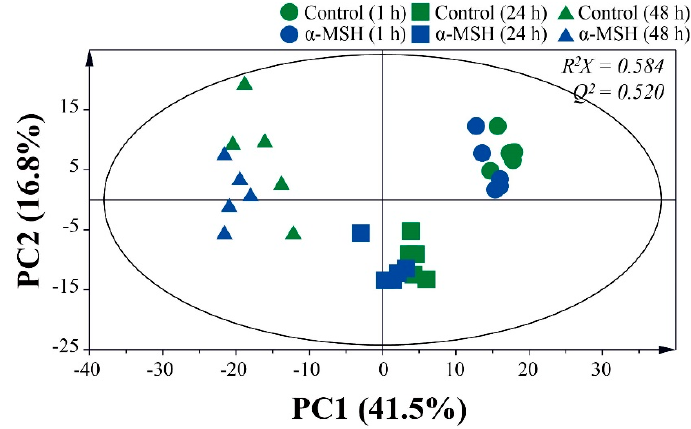
Figure 1. Principal component analysis (PCA) score plot based on the gas chromatography-mass spectrometry (GC-MS) data sets during 48 h of melanoma cell culture. spectrometry (GC-MS) data sets during 48 h of melanoma cell